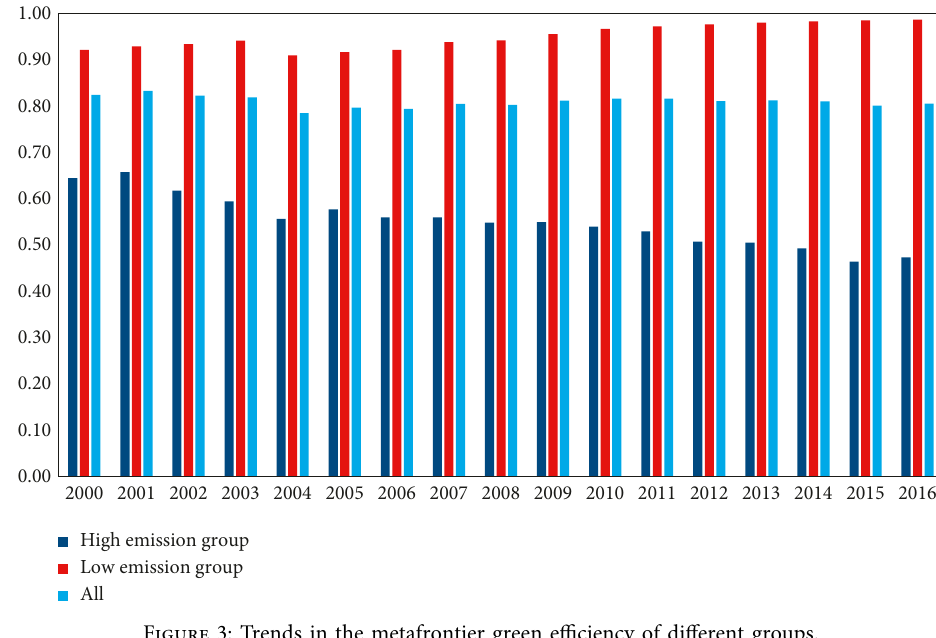
Figure 3: Trends in the metafrontier green efficiency of different